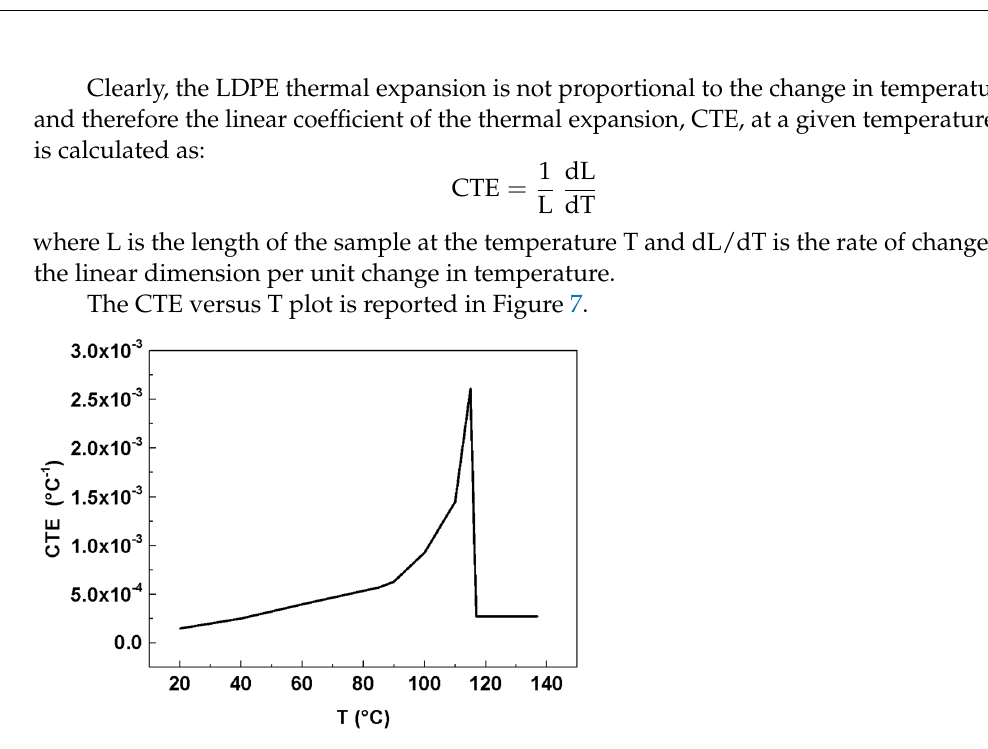
Figure 6. Linear strain ε vs temperature, T, of an LDPE substrate.